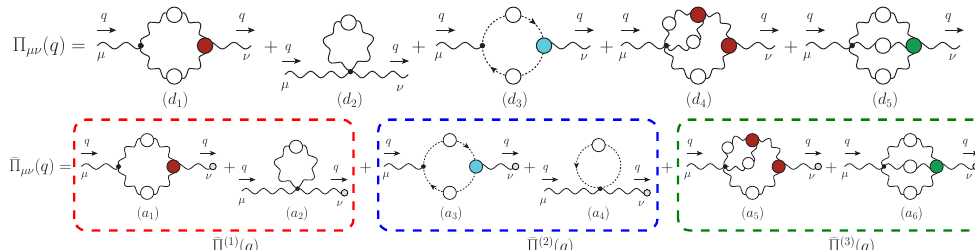
Figure 1. Upper panel: the diagrammatic representation of the conventional gluon self-energy, Π µν ( q ) . Bottom panel: the diagrammatic representation of the Q the grey circles at the end of the gluon lines indicate a background gluon. The corresponding Feynman rules are given in Appendix B of